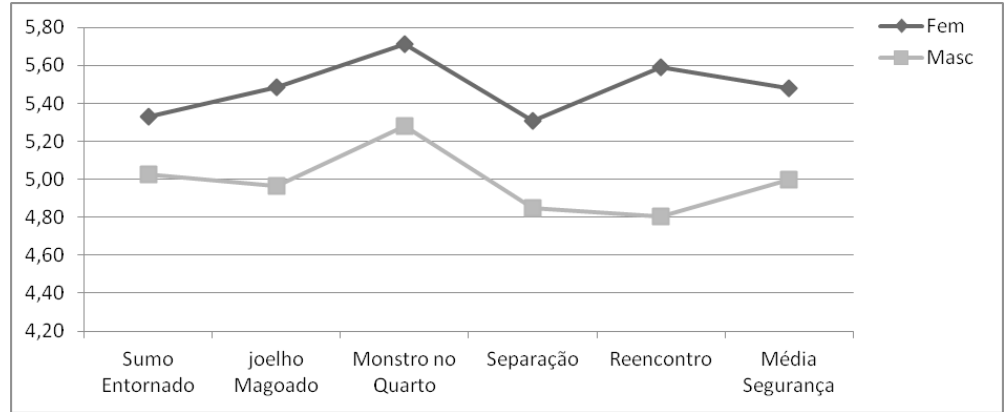
Figura 1 . Caracterização gráfica das pontuações obtidas por meninos e meninas na média da segurança e nas diferentes histórias do